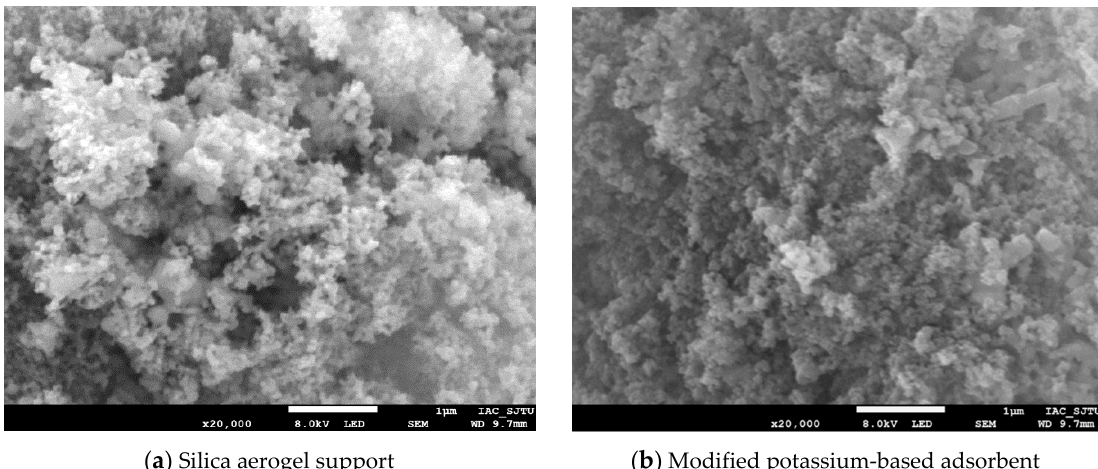
Figure 3. SEM image of support and adsorbent.